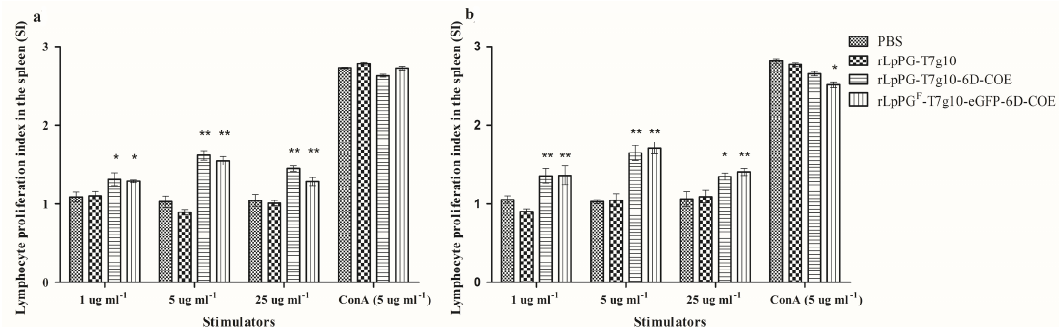
Figure 7. Proliferation of T lymphocytes from immunized mice. Lymphocyte proliferation was determined by 3-(4,5-dimethylthylthiazol-2-yl)-2,5-diphenyltetrazoliumbromide (MTT) assay with recombinant core neutralizing epitope (COE) protein ( a ) or D protein ( b ) as stimulating agents and concanavalin A (ConA) as a positive control. * p < 0.05, ** p < 0.01 vs. phosphate-buffered saline (PBS) and vector control groups.